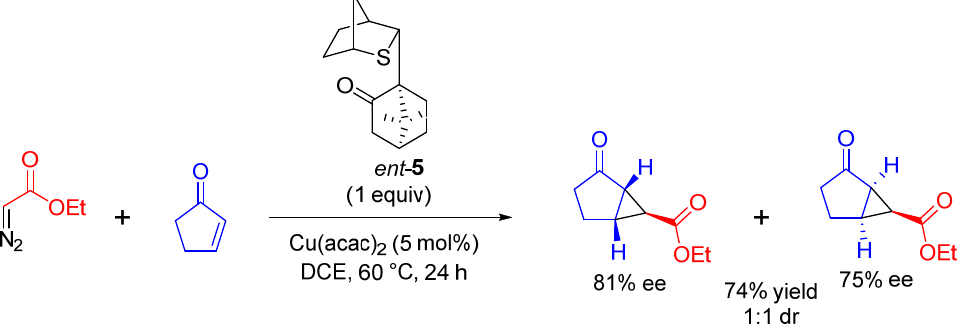
Scheme 37. Aggarwal’s sulfide-promoted enantioselective cyclopropanation.